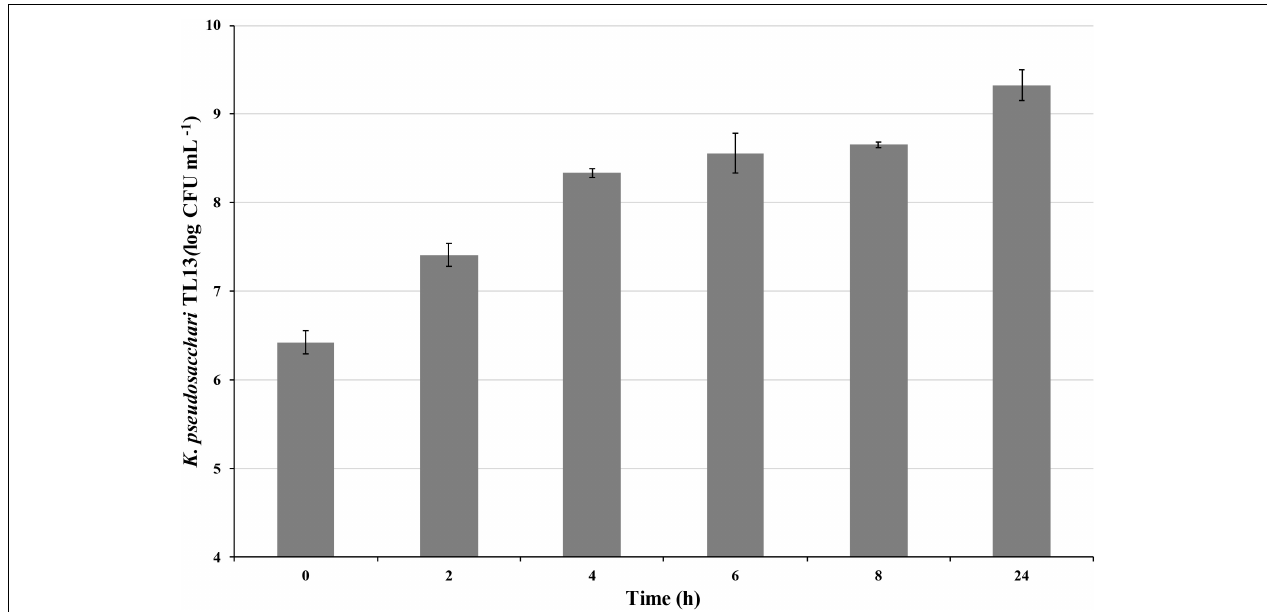
FIGURE 4 | Viable count of Kosakonia pseudosacchari TL13 during its growth in 10 L fermentor at 30 ◦ C, pH 7.00, shaking at 130 rpm and air sparging at 0.5 vvm. The error bars represent the means ± SD of two replicates.